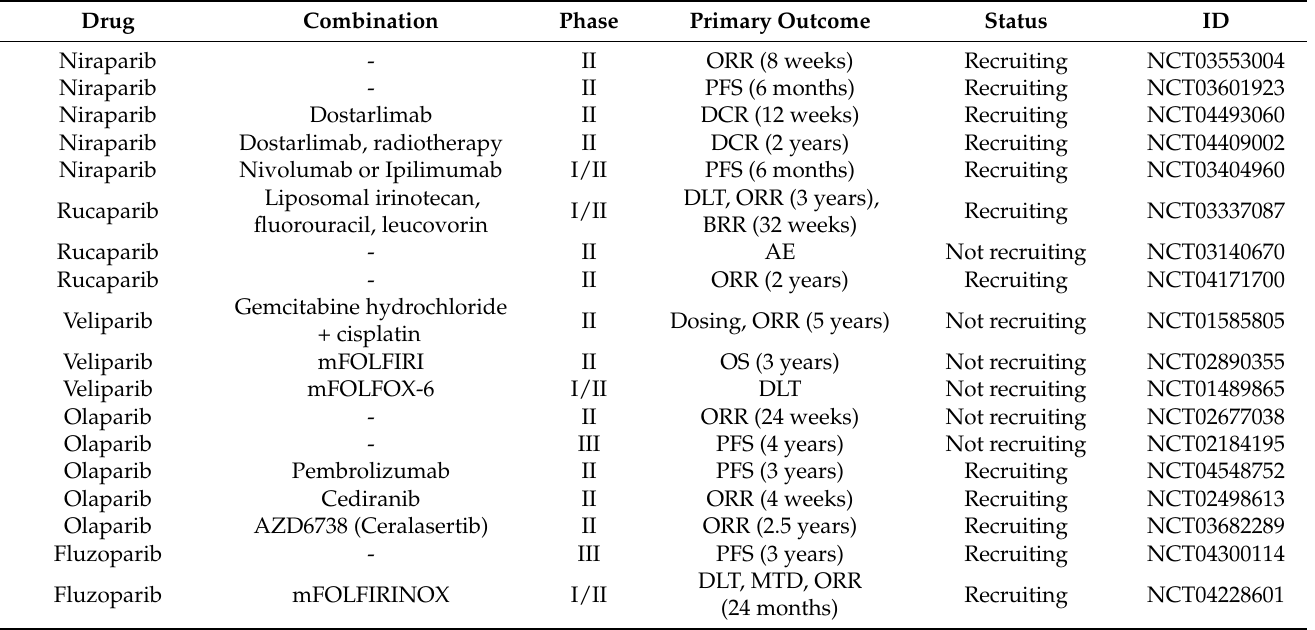
best response rate; AE, adverse events; OS, overall survival; MTD, maximum tolerated dose.